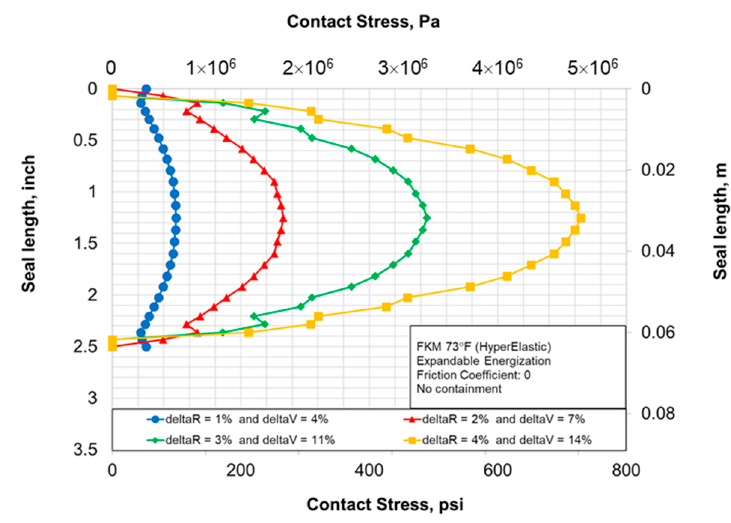
Figure 14. Contact stress profiles in expandable seal assembly for hyper-elastic FKM.